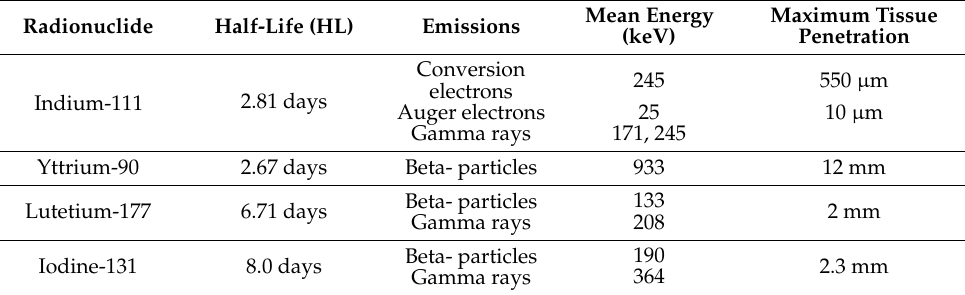
Table 2. Physical characteristics of some key radionuclides proposed for